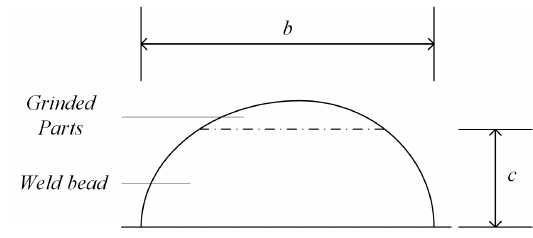
Figure 13. Welding-related parameters.